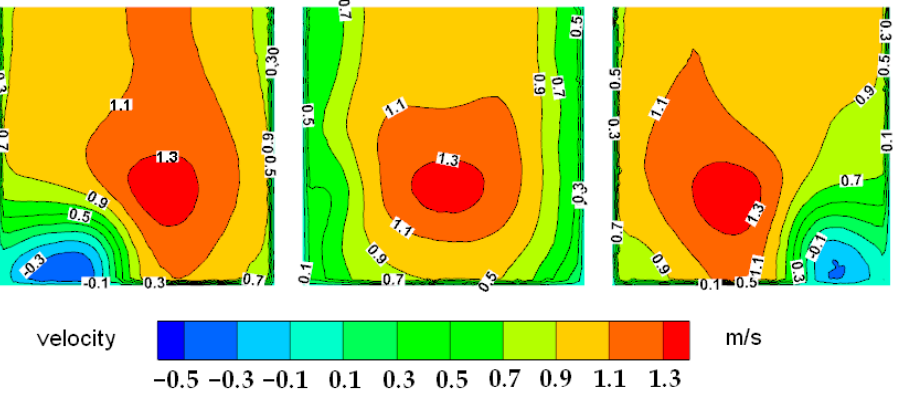
Figure 16. Contour map of inlet section velocity in the original scheme 1.